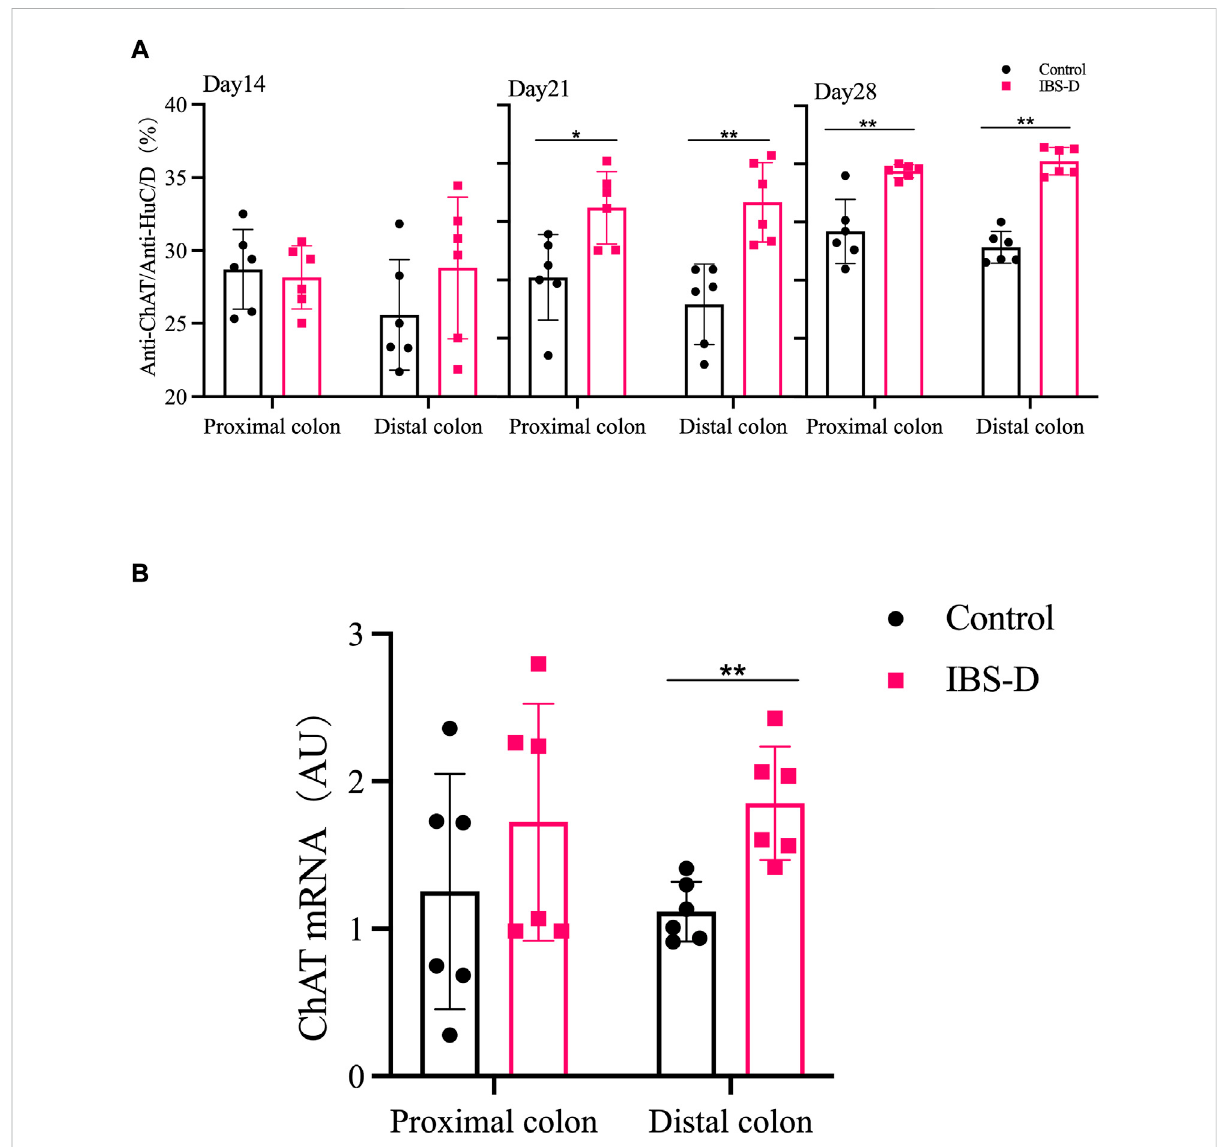
FIGURE 8 (A) The proportion of ChAT positive neurons in the distal and proximal colon. (B) ChAT mRNA expression in model groups. RNA was isolated with TRIzol reagent and qRT-PCR was used to analyze the gene expression of ChAT. The GAPDH gene was used as internal reference. Data